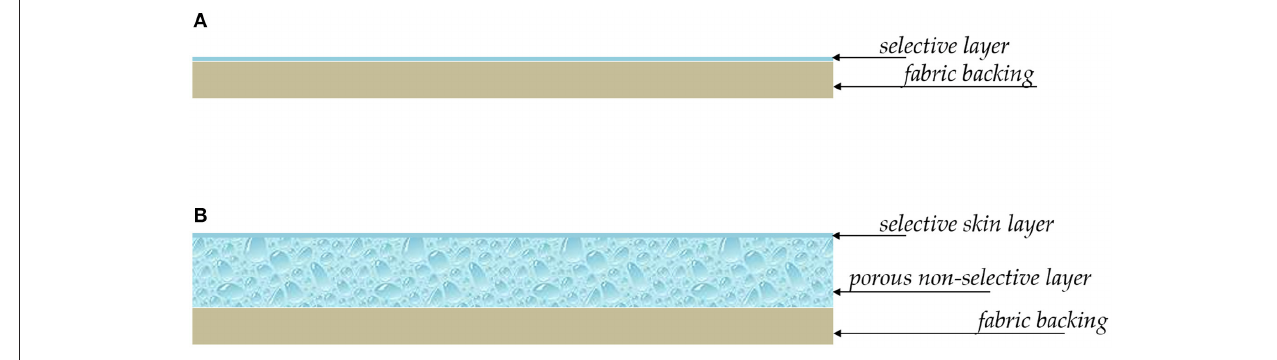
FIGURE 7 | Structure of composite (A) and asymmetric (B) membranes for OSN.